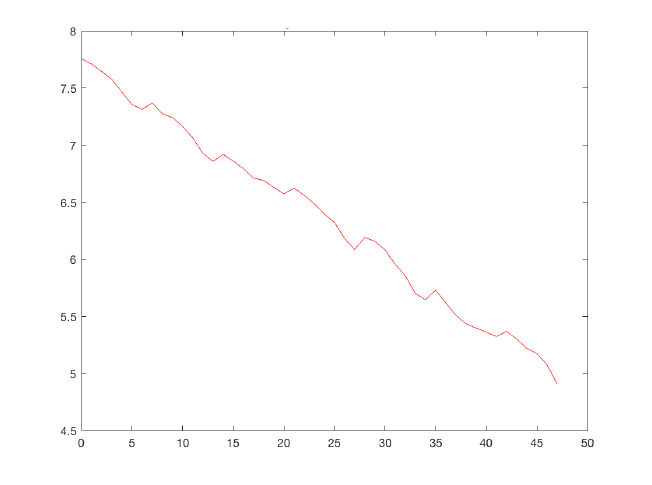
Figure A14. Cont